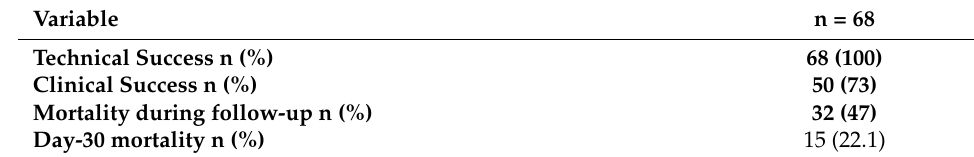
Table 4. Outcome of the 68 patients included in the